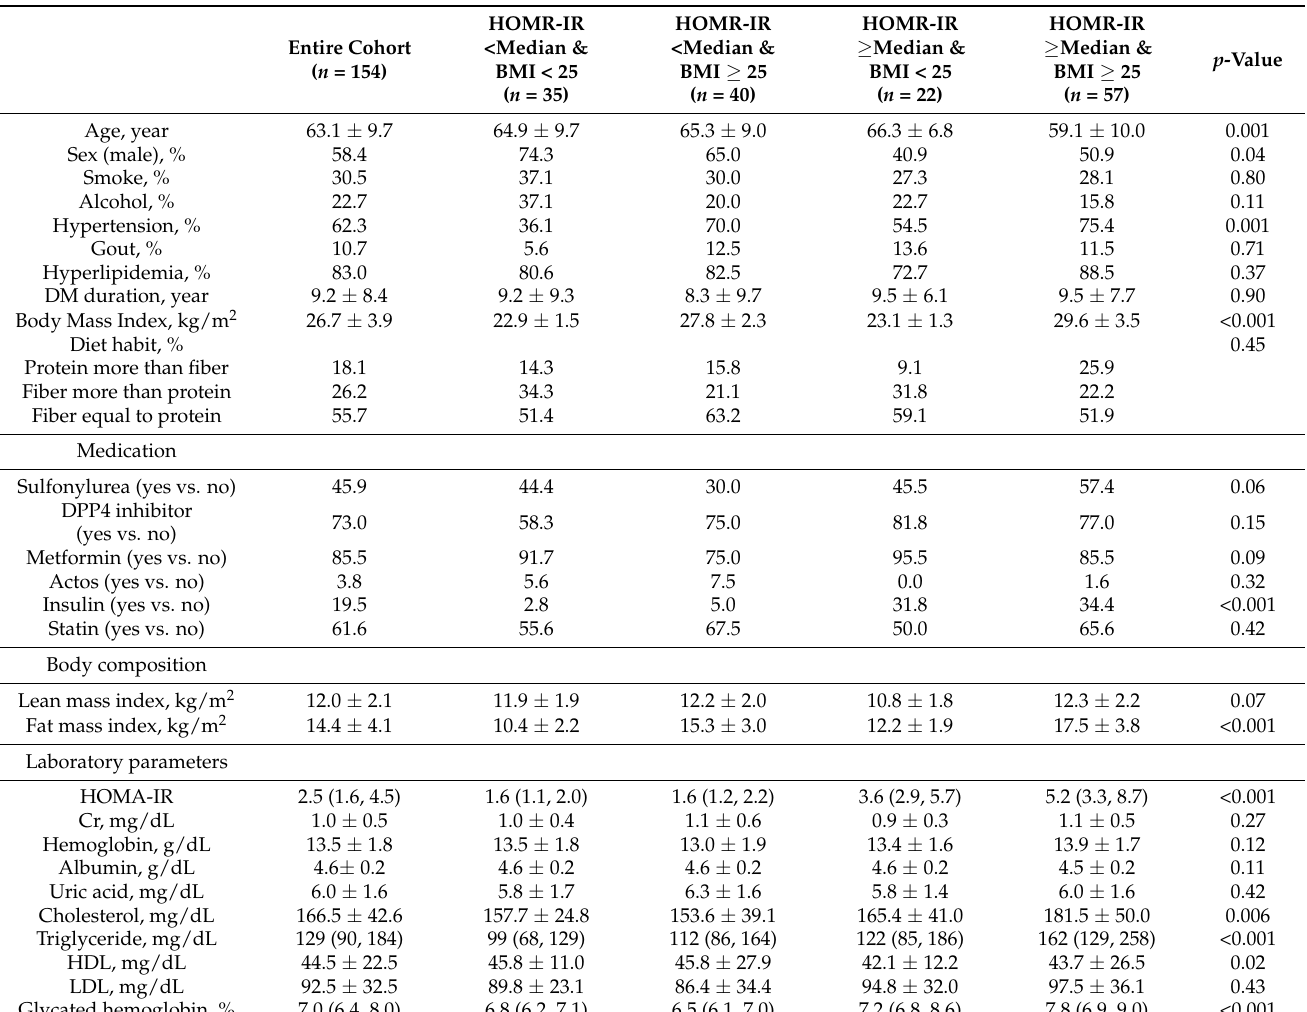
Table 1. The characteristics of study participants stratified by the median of HOMA-IR and BMI of 25 kg/m 2 .